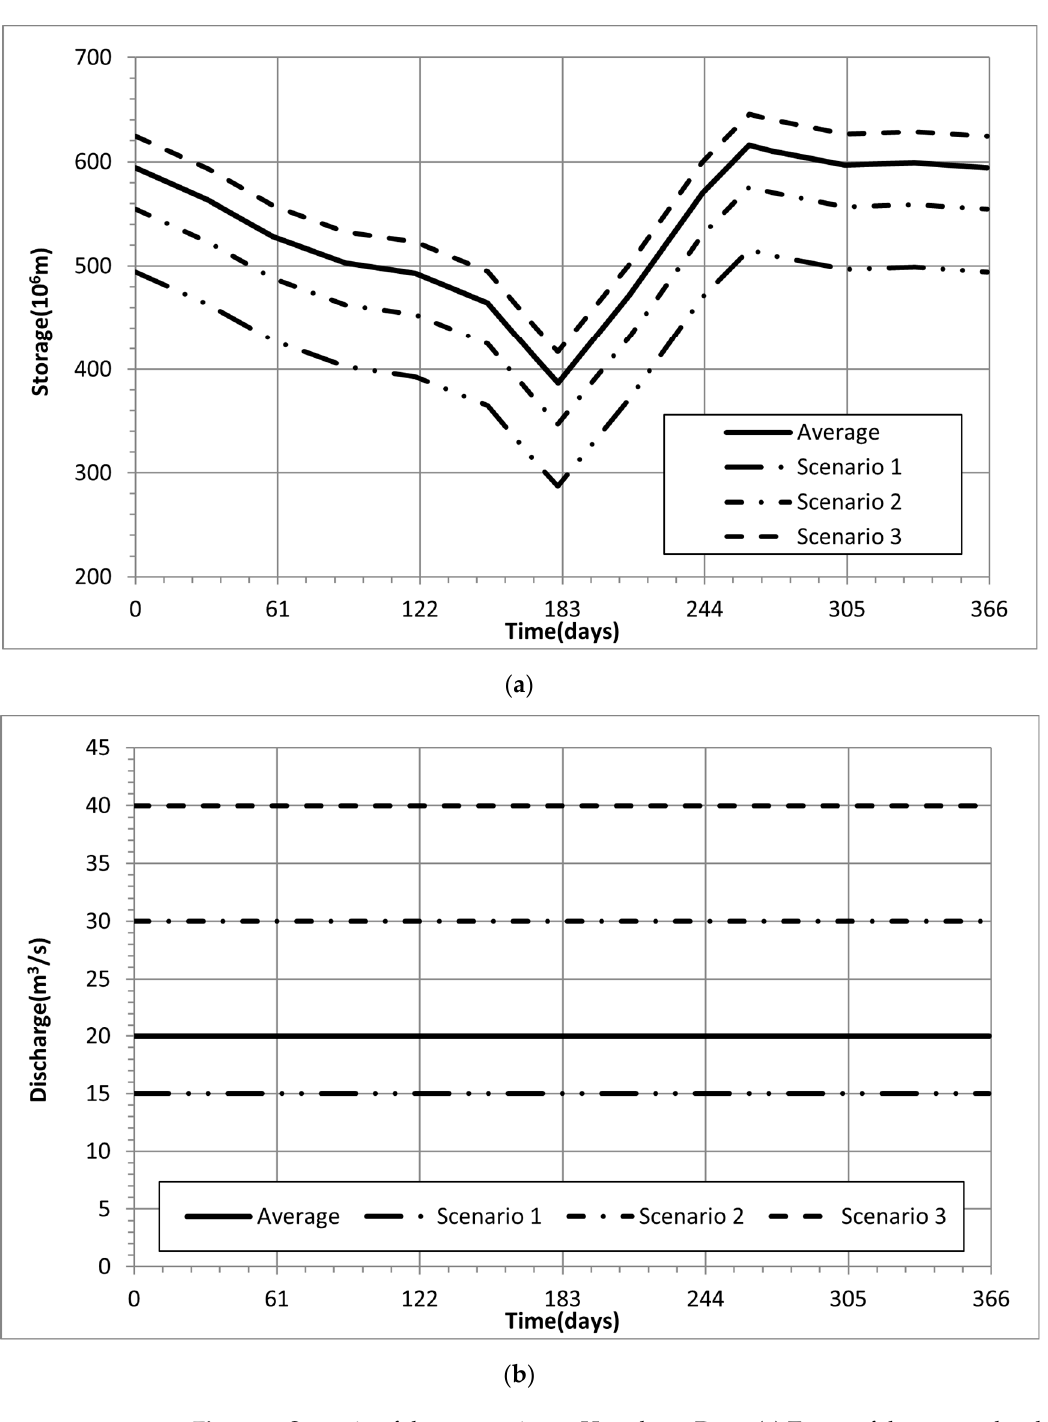
Figure 6. Scenario of dam operation at Hwacheon Dam. ( a ) Target of dam water level; ( b ) Target of outflow discharge. outflow